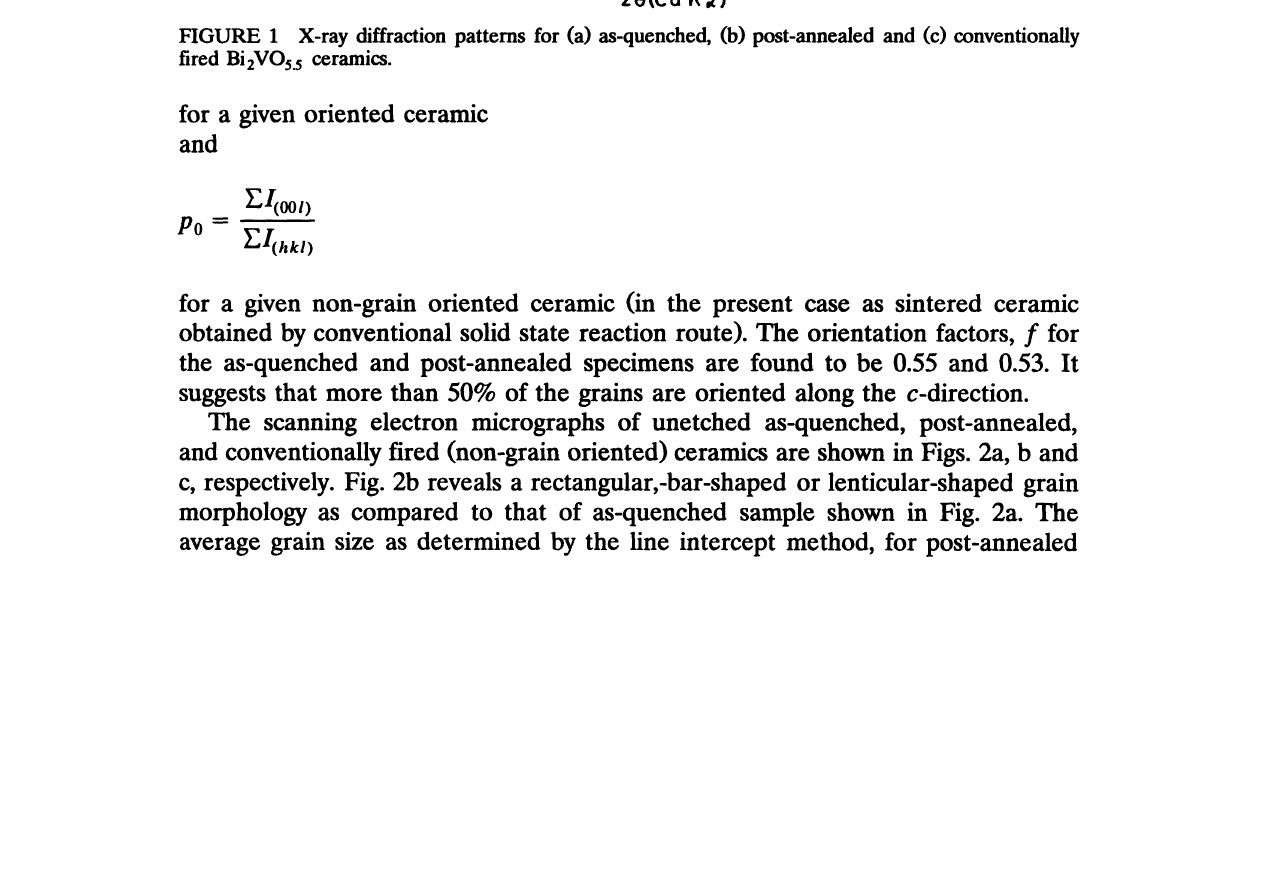
FIGURE 1 X-ray diffraction patterns for (a) as-quenched, (b) post-annealed and (c) conventionally fired Bi2VO5 ceramics. for a given oriented ceramic and